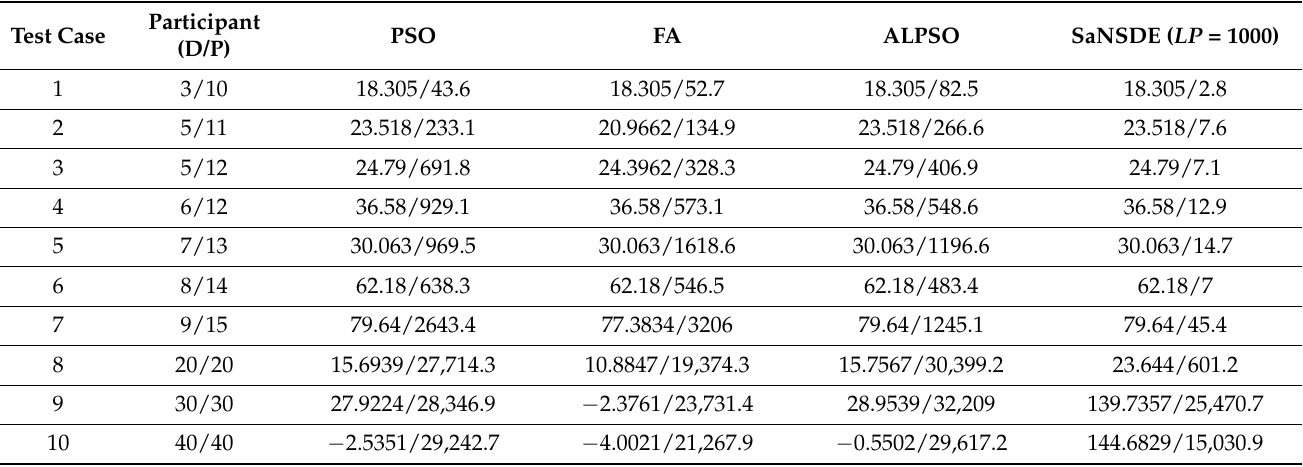
Table 20. Average fitness values and average number of generations for PSO, FA and SaNSDE with algorithmic parameter LP =